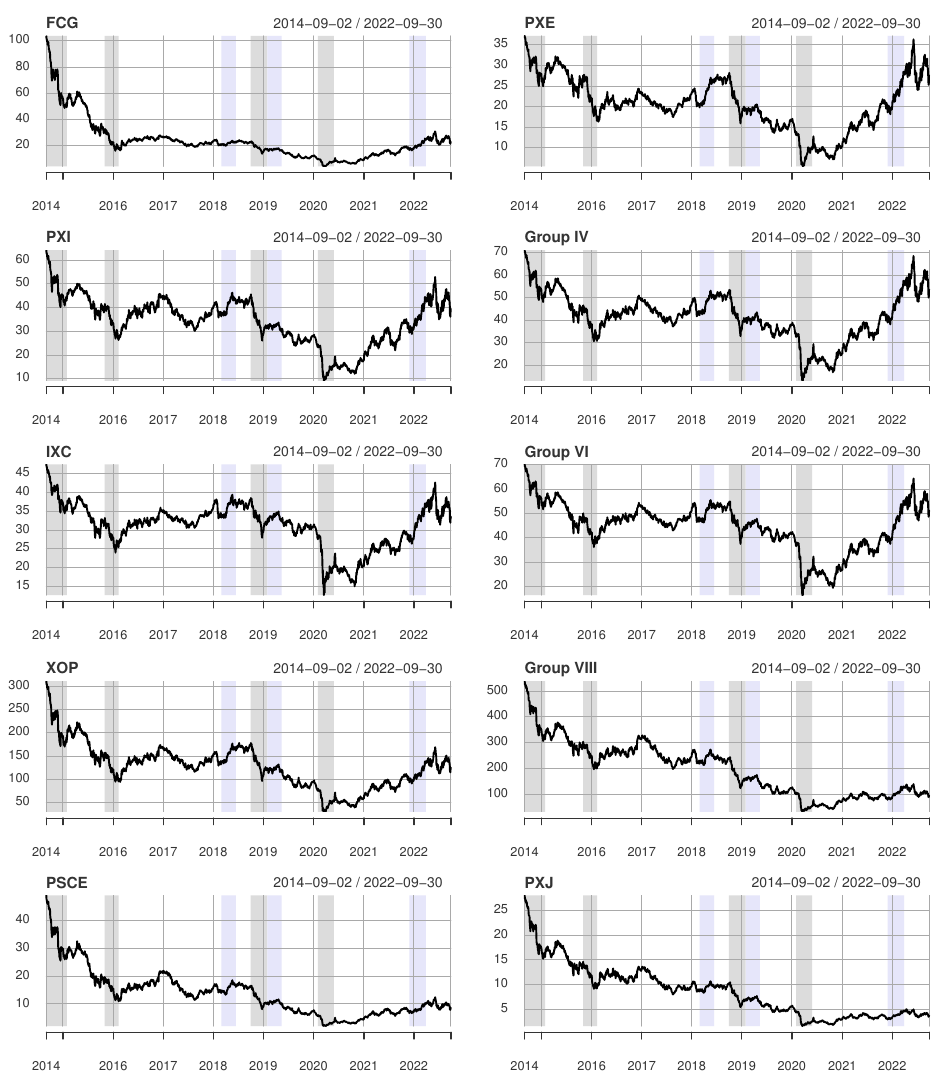
Figure A3. Prices of oil, gas and